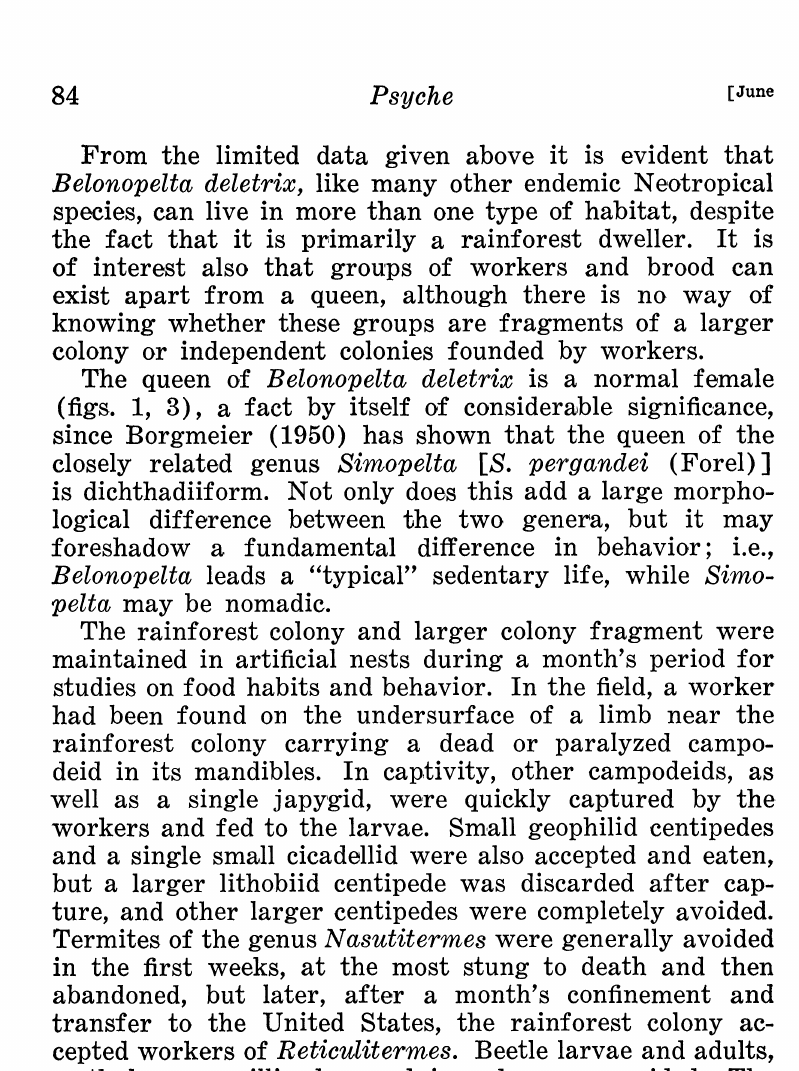
Figs. 1-4, Belonopelta deletrix Mann. 1, head of queen. 2, head of worker. 3, queen, side view. 4, worker, side